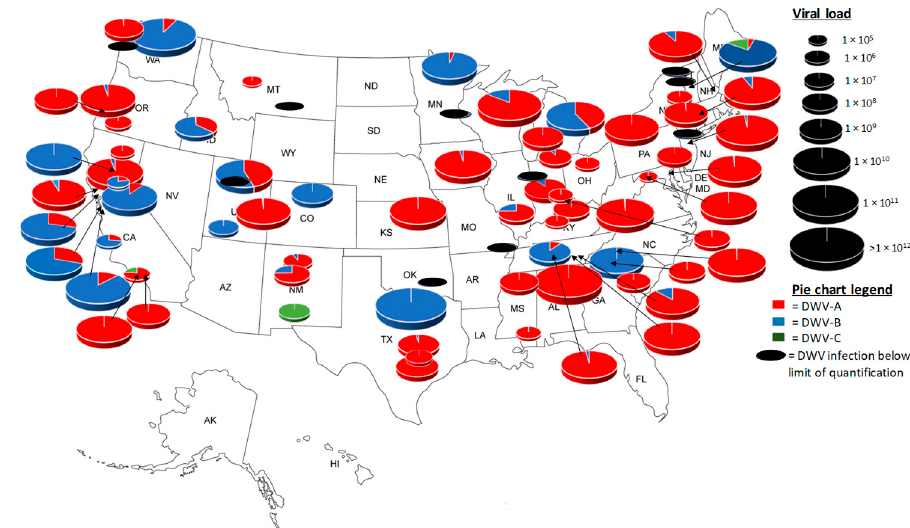
Figure 4. A map of the United States showing the average DWV load and variant per apiary in pre-wintering honey bees, 2016. Size of pie chart is relative to total DWV load per apiary.